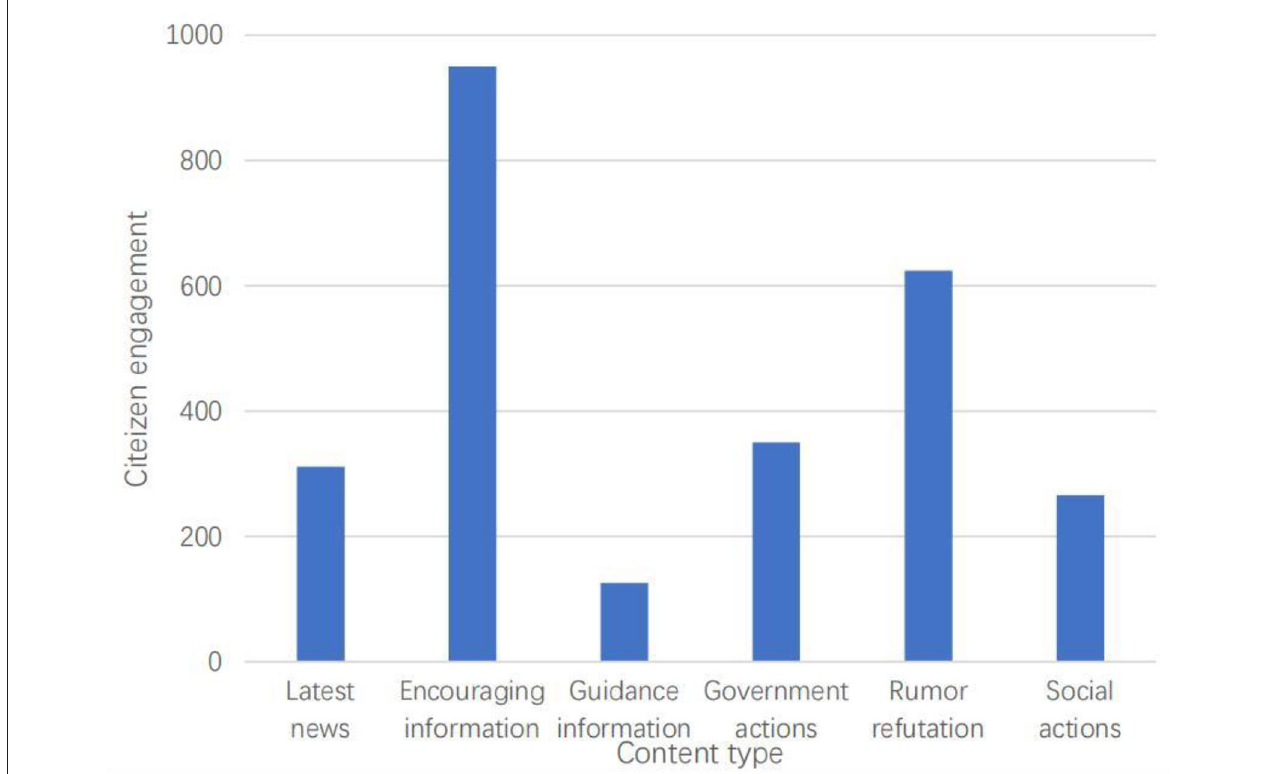
FIGURE 2 | Average volume of citizen engagement grouped by content